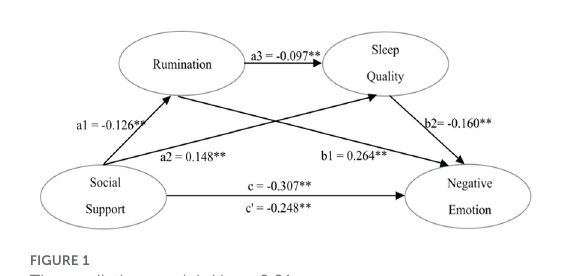
FIGURE1 The mediation model. ** p <